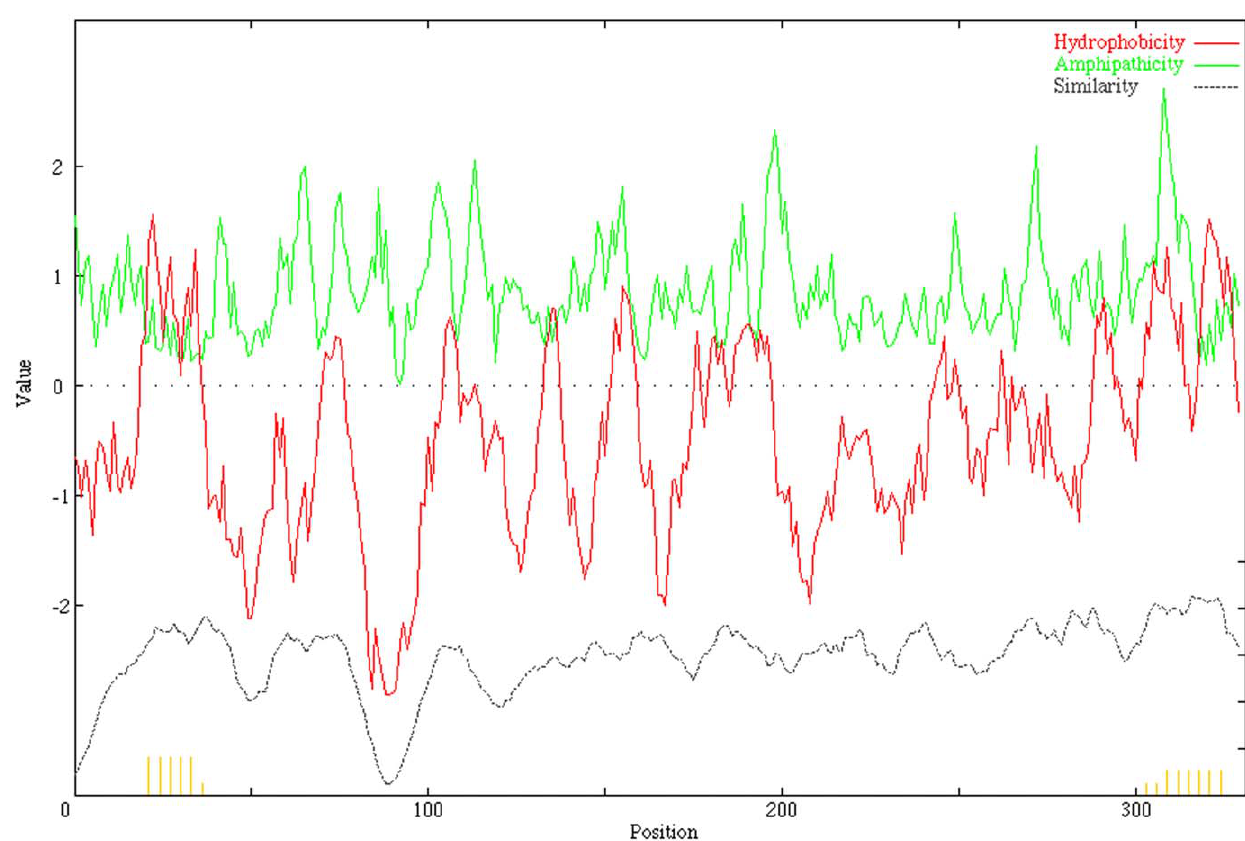
Figure 3. Average hydropathy, amphipathicity and similarity plot of 18 DUF3233 representative sequences. The plot shows 12 hydrophobic (green) and amphipathic (red) peaks corresponding to possible transmembrane beta-strand forming segments The plot was generated using AveHAS program.